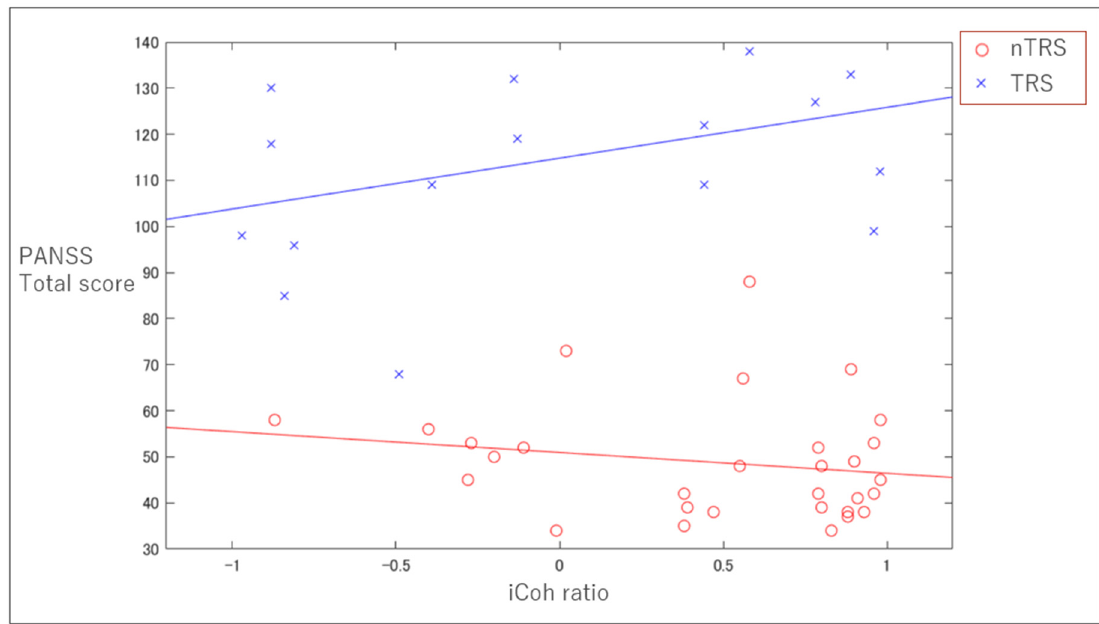
Figure 2. The relationship between the iCho ratio for the left delta PCC–ACC connectivity and positive and negative syndrome scale (PANSS) total score. In patients with TRS, there is trend toward a relationship (r = 0.38, p = 0.069), but not for the nTRS group (r = − 0.18, p = 0.17).